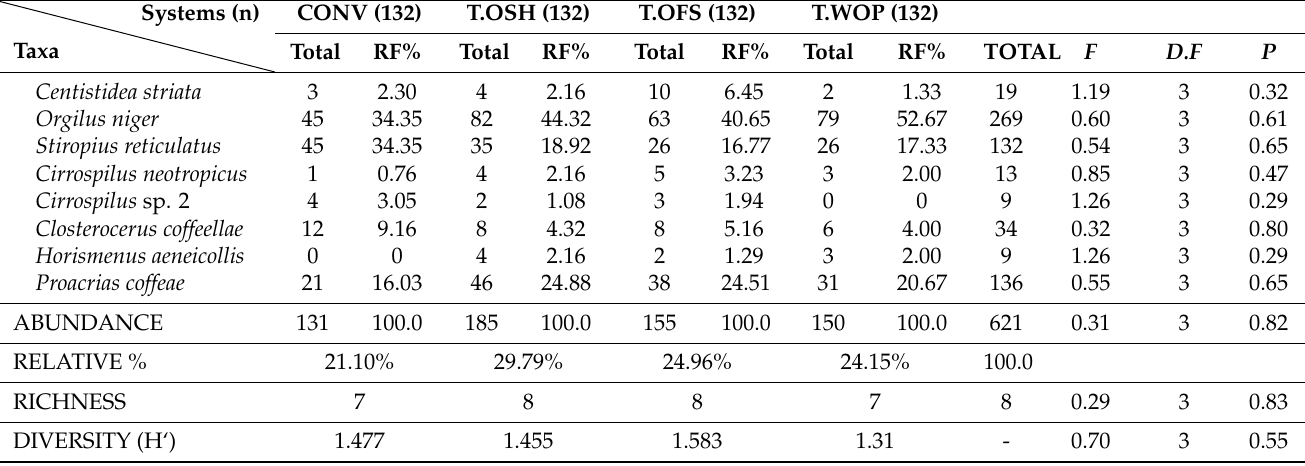
Table 2. Total abundance, relative frequency (RF%), richness, and Shannon diversity index (H’) of the hymenopteran species associated with the coffee leaf miner Leucoptera coffeella in coffee plants ( Coffea arabica ) in Campo do Meio and Guap é , MG,